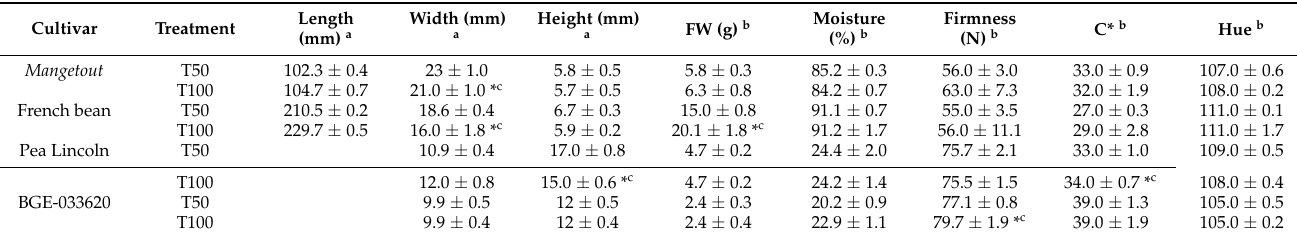
Table 2. Physical parameters of pea, French beans and mangetout grown under normal (T100) and sustained deficit (T50) fertigation tested under protected cultivation conditions. Data are displayed as mean ± standard deviation.